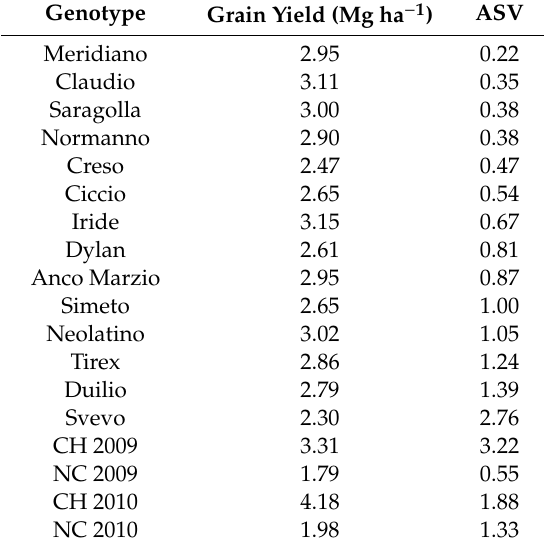
Table 6. AMMI stability value (ASV) of durum wheats under chemical input and no-chemical input management systems in two subsequent growing